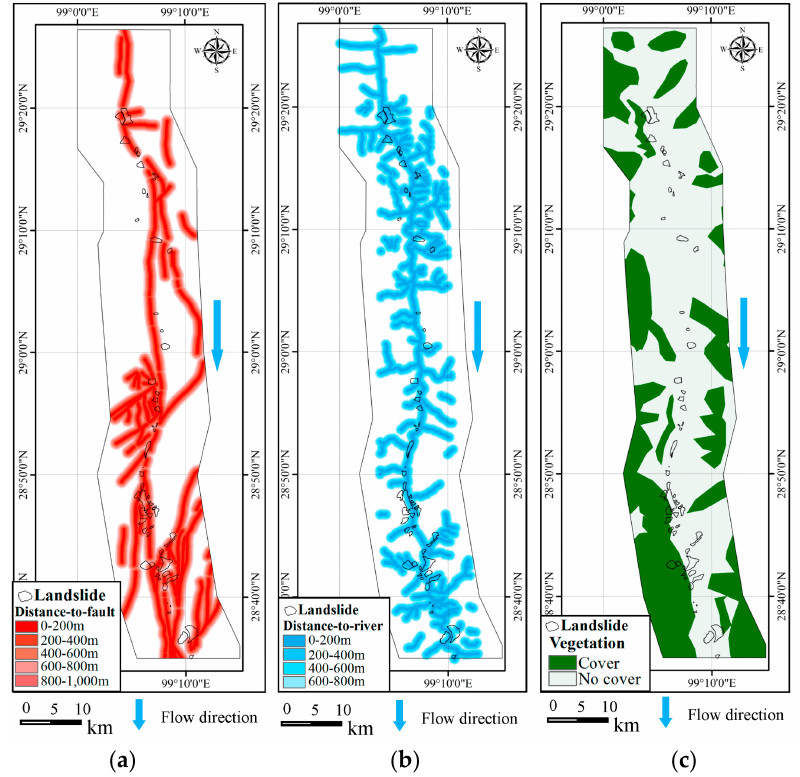
Figure 6. Influencing indicators maps of the study area: ( a ) distance-to-fault; ( b ) distance-to-river; and ( c ) vegetation.